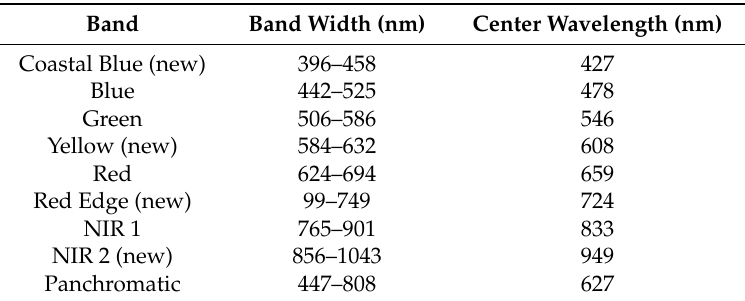
Table 1. WorldView-2